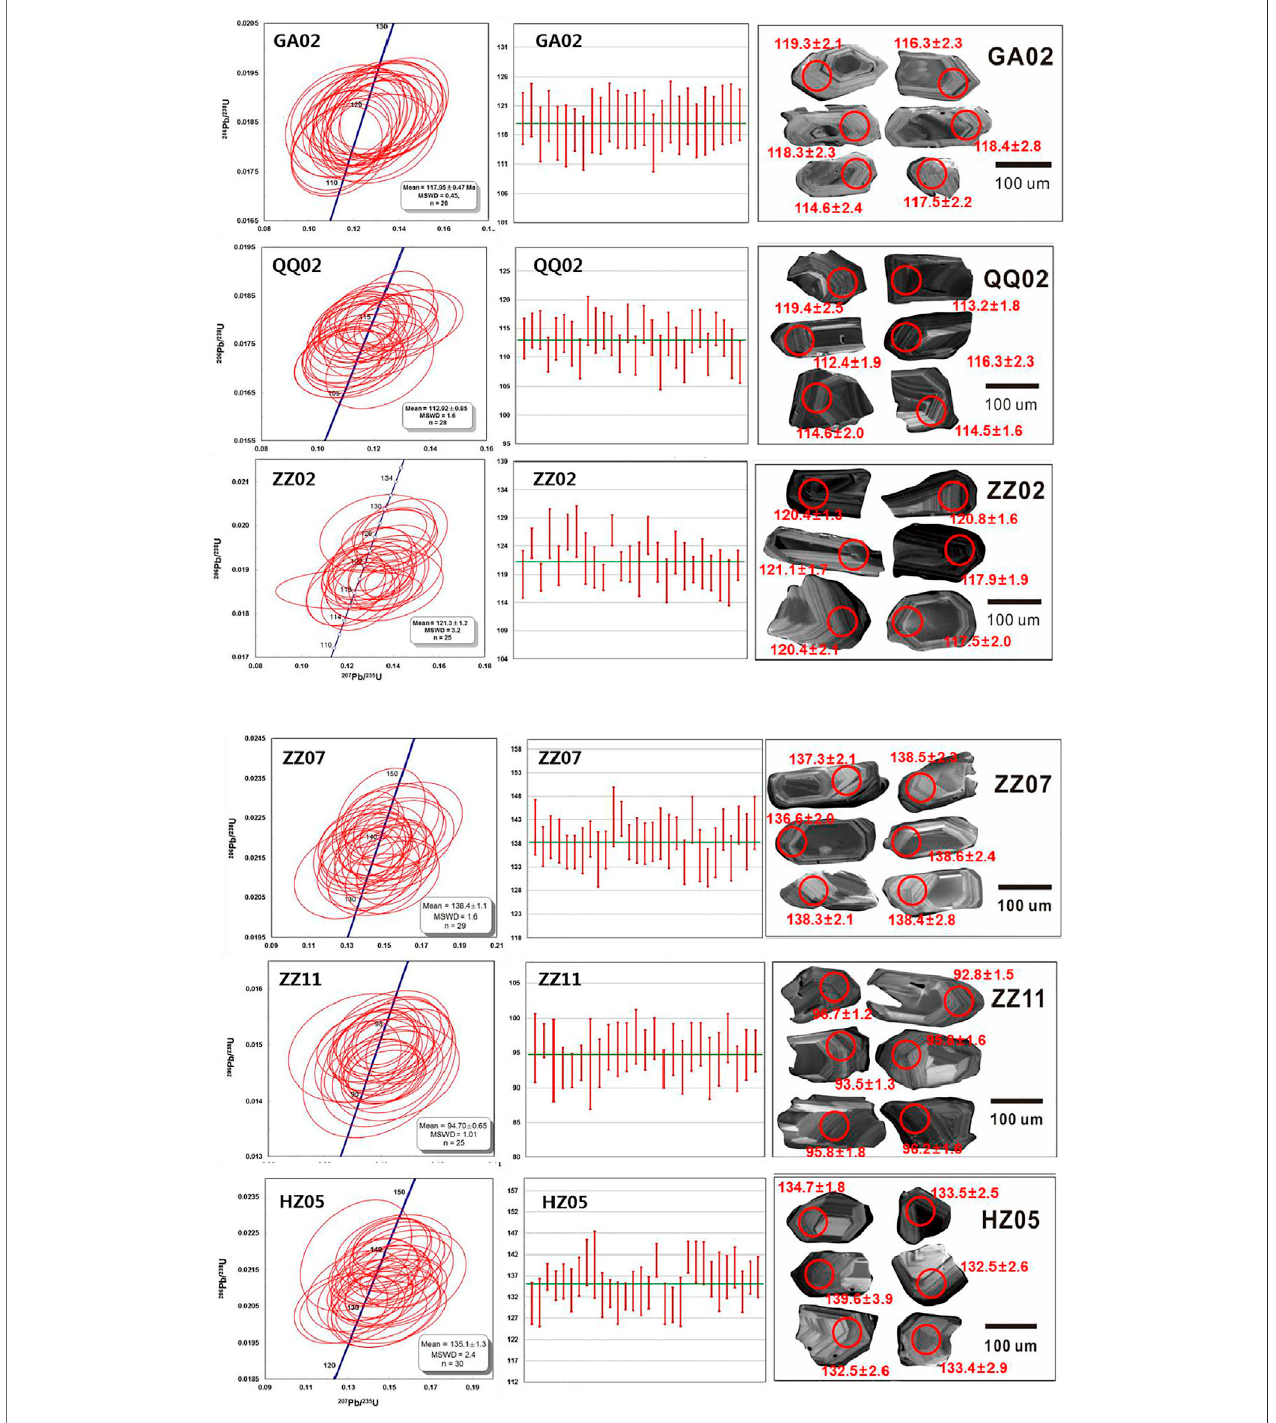
FIGURE 6 | The 206 Pb/ 238 U- 207 Pb/ 235 U concordia plot and the weighted mean age of representative zircons of the granites.